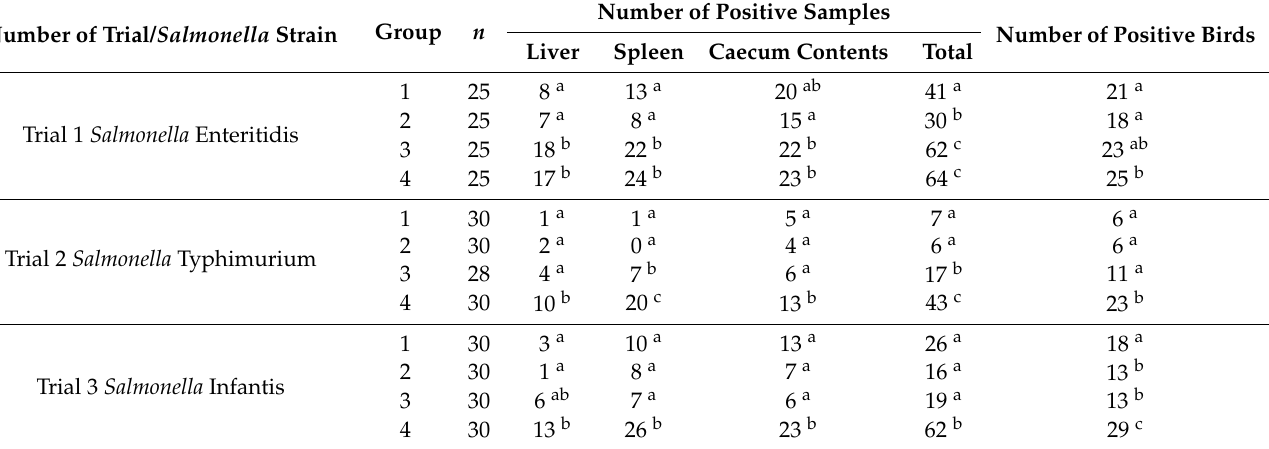
Table 3. The total isolation rates of S. Enteritidis, S. Typhimurium, or S. Infantis from livers, spleens, and caecum contents after challenge. Samples were taken from five (Trial 1) or six (Trials 2 and 3) birds of each group on days 3, 6, 9, 12, and 15 post-challenge. A chicken was considered positive if at least one sample was